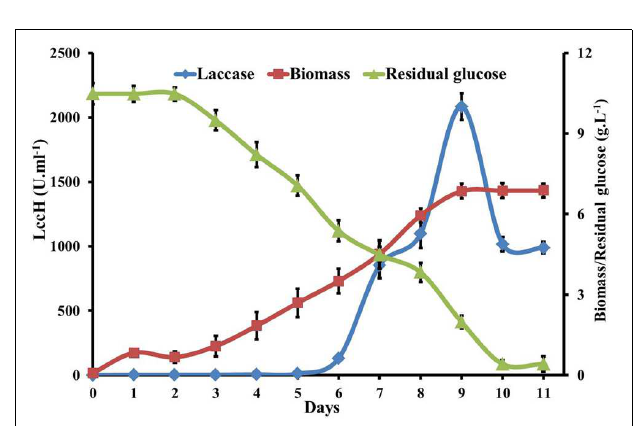
FIGURE 6 | Substrate specificity of LccH. All the substrates were tested at 3 mM concentrations using citrate phosphate buffer pH 3.4 and the laccase activity was monitored under standard assay conditions. Activity with ABTS was considered as